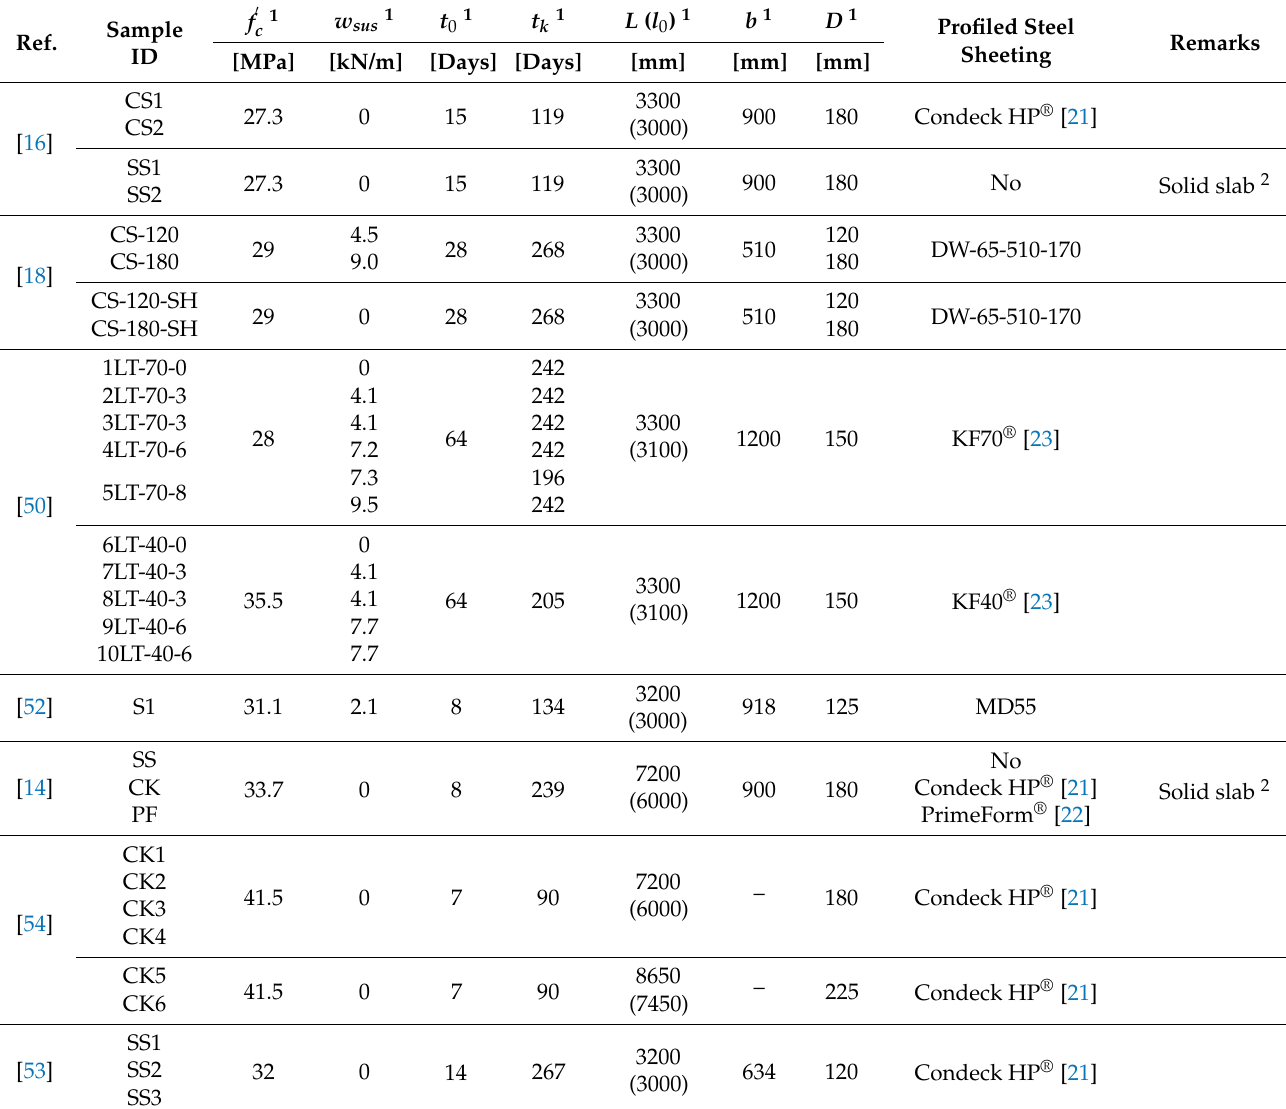
Table 2. Long-term tests of simply-supported composite